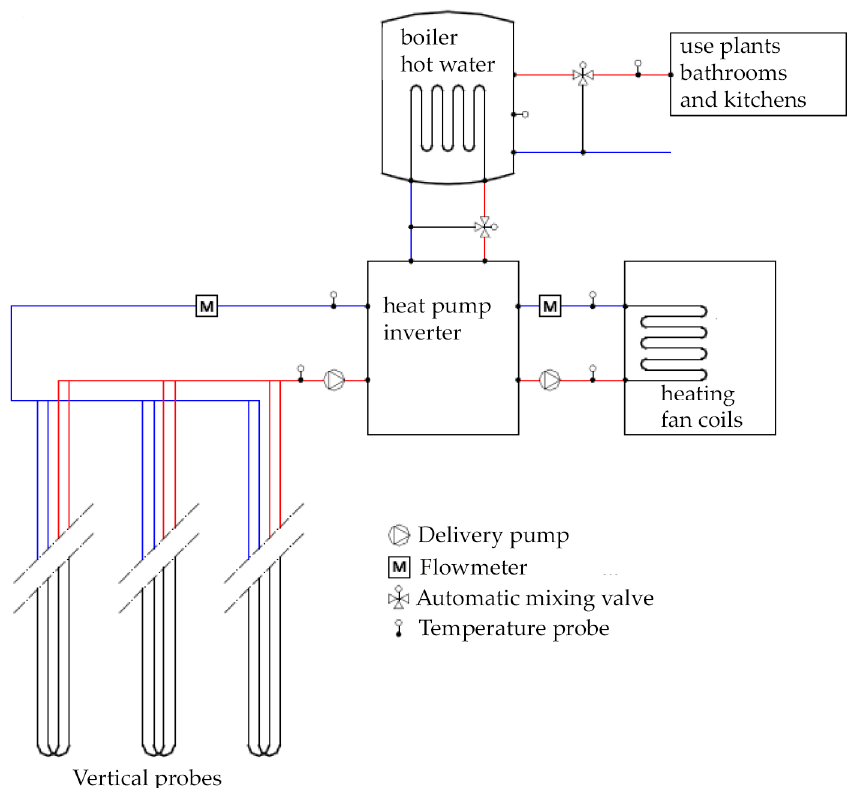
Figure 5. Geothermal plant scheme.